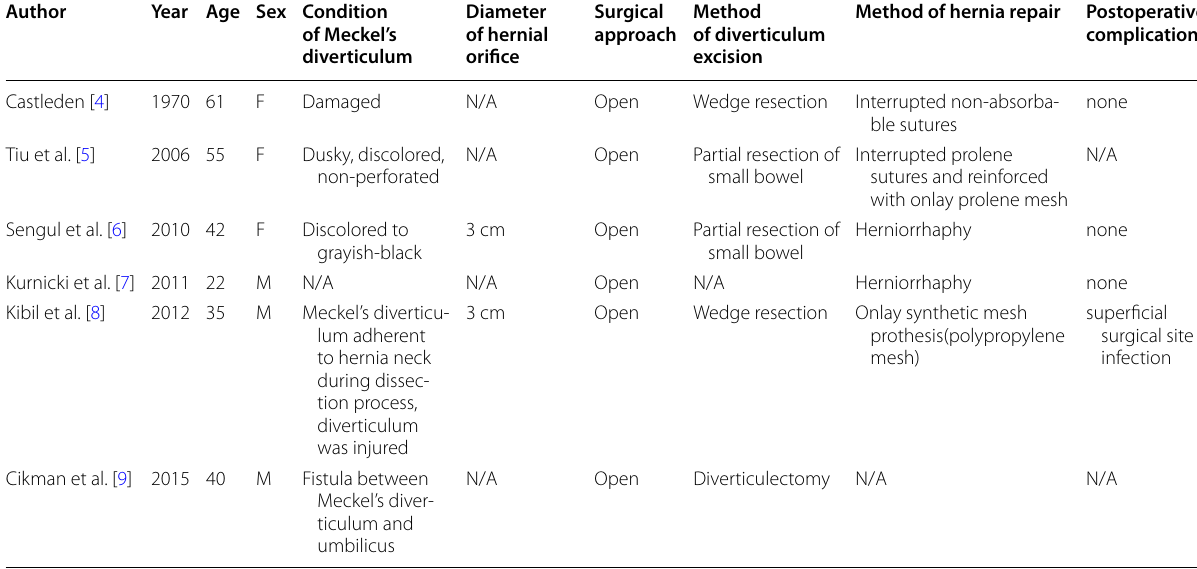
N/A not available, M male, F female, Open open